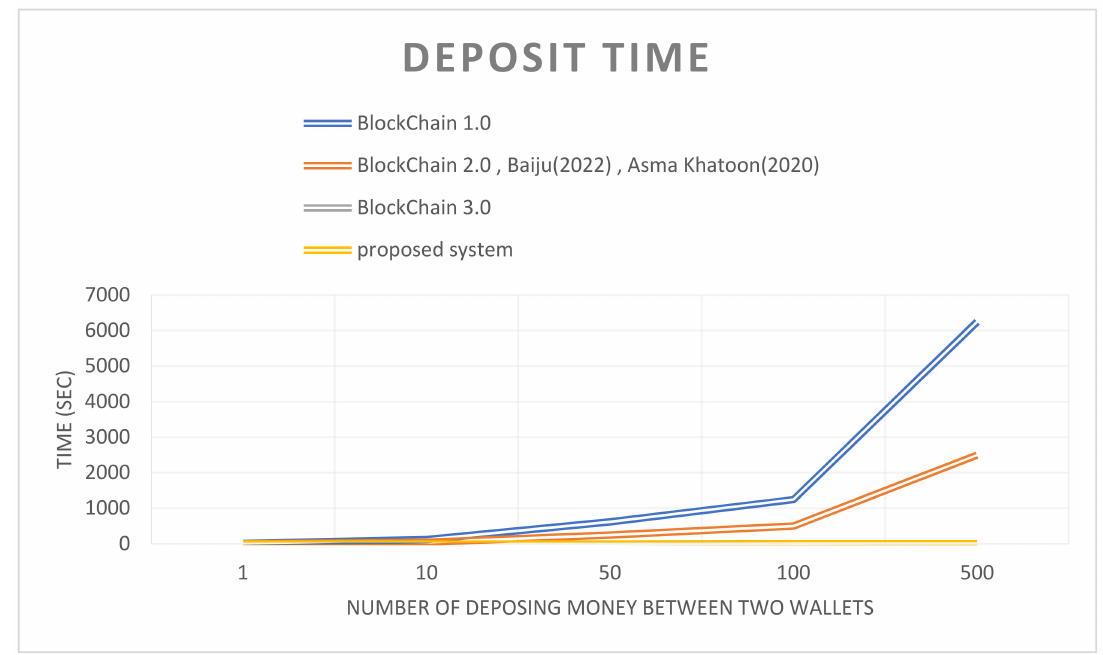
Figure 6. Deposit time comparison between proposed method and blockchain